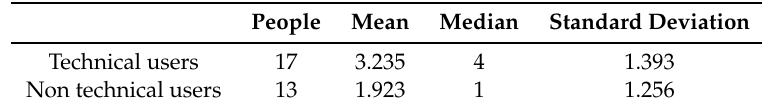
Table 2. Variability on the validation of ditch technique between users with and without previous technical